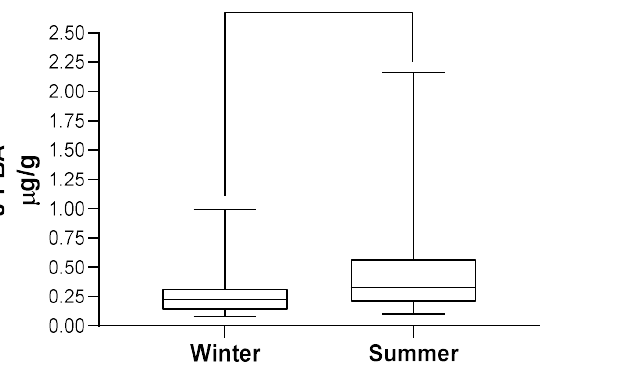
Figure 2. 3-PBA urinary excretion according to season of urine collection. In each box, the central horizontal line marks the median value. * p < 0.001.